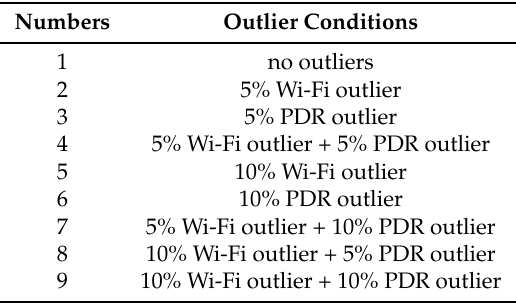
Figure 10. Average positioning comparisons of our method, the Kalman filter based method and the particle filter based method over different outlier conditions. Table 6. The numbers and their corresponding outlier